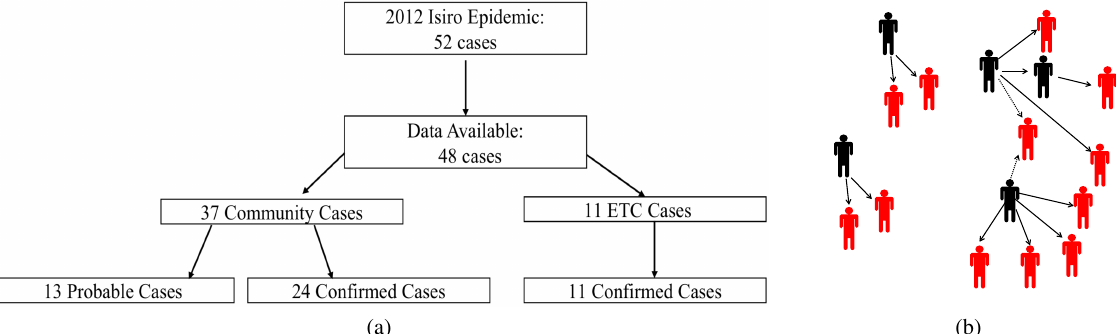
Fig. 1: 2012 Isiro EVD data and model. Panel (a): Summary of available Isiro cases used in current analysis of the transmission dynamics in the community and ETC. This data is a subset of 52 cases described in [49]. Panel (b): Example of transmission data reconstructed from the Isiro outbreak files. Dark figures represent primary cases and secondary cases who infected others. All others represent infected who did not transmit. All cases of transmission ambiguity (multiple in-arrows) were resolved uniformly at